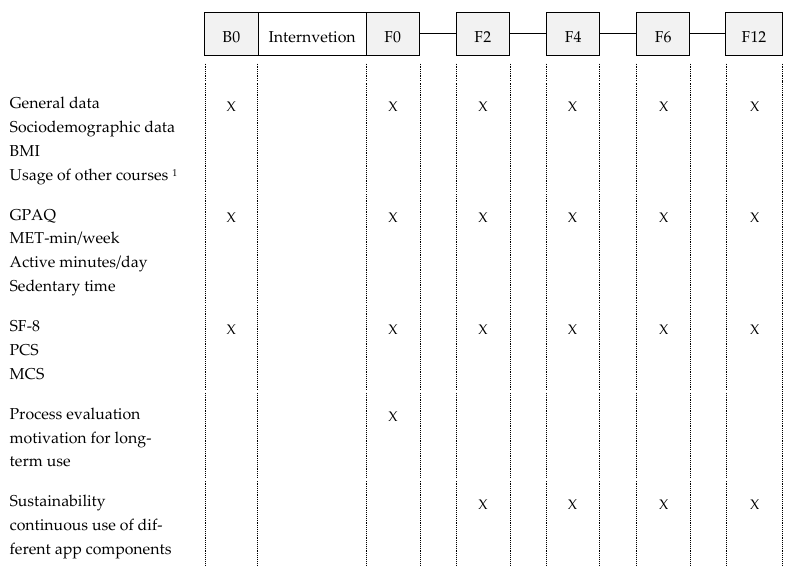
Figure 1. Study concept: measurement points and methods. 1 other analogue or digital lifestyle interventions than “VIDEA bewegt”. Abbreviations: B0, baseline; F0, end of intervention; F2, two months after the program; F4, four months after the program; F6, six months after the program; F12, twelve months after the program; GPAQ, Global Physical Activity Questionnaire, MET = metabolic equivalent, SF-8 = Short Form Health Survey; PCS, Physical Component Summary Score; MCS, Mental Component Summary Score.